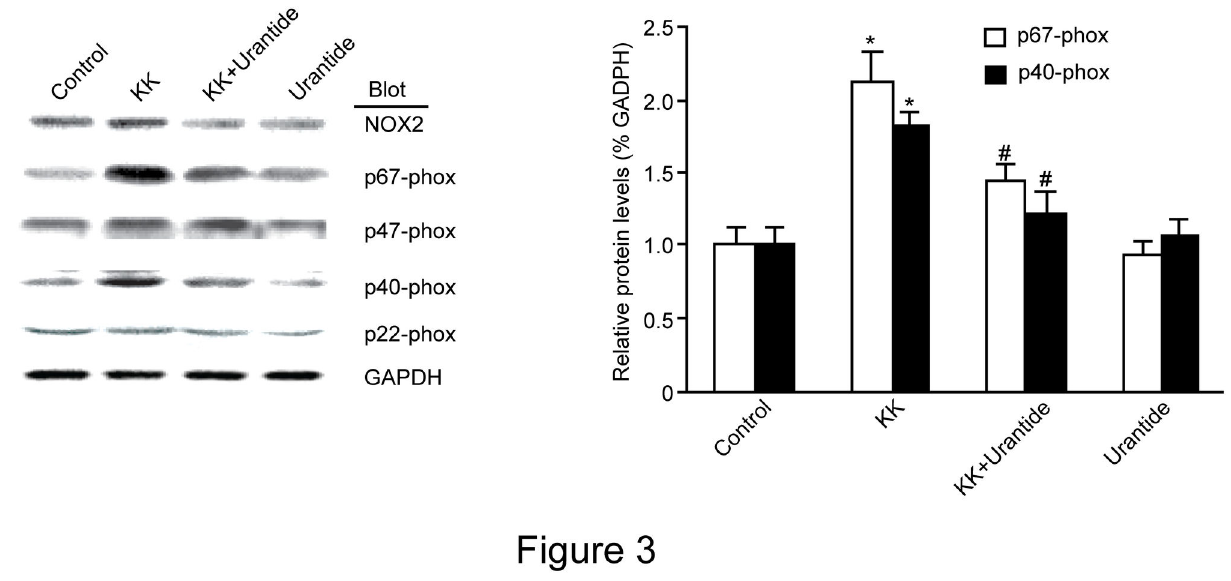
Figure 3. Effect of urantide on NADPH oxidase subunit expression in soleus muscle in mice. KK mice were administrated urantide (30 µg/kg/day) for 14 days prior to western blot analysis with antibodies against NOX2, p67-phox, p47-phox, p40 phox and p22 phox . Equal loading was confirmed by reprobing the membranes with GAPDH antibody. Control: C57BL/6J mice were treated with saline for 14 days; Urantide: C57BL/6J mice were treated with urantide for 14 days; KK:KK mice were treated with saline for 14 days; KK+Urantide: KK mice were treated with urantide for 14 days. Data are presented as the relative increase compared with control (100%; n=3, * P <0.05 vs control; # P <0.05 vs KK group). doi: